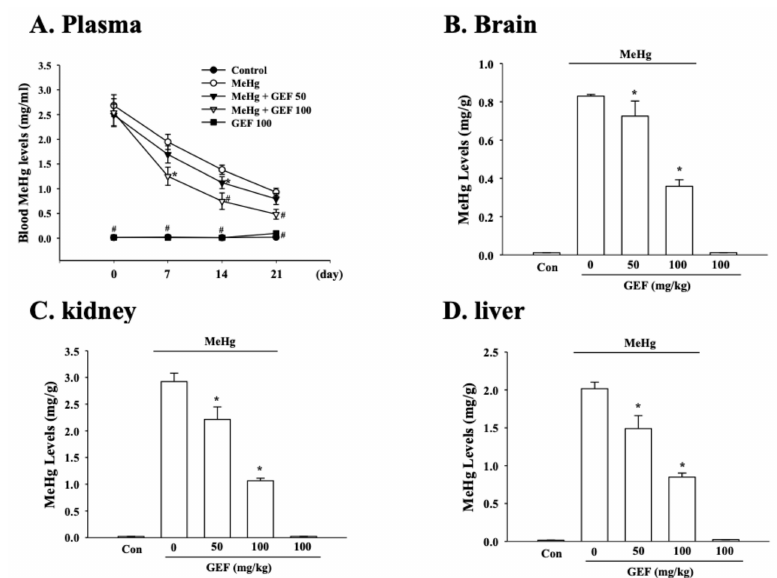
Figure 5. E ff ects of GEF on MeHg elimination after oral administration of MeHg. ( A ) Long-term treatment of GEF (50 and 100 mg / kg, 3 weeks, p.o.) after oral administration of MeHg (2 mg / kg, 3 weeks, p.o.) decreased plasma MeHg concentration with dose- and time-dependent manners. Each group are obtained plasma in every 7 day. ( B ) GEF eliminated brain MeHg concentration with dose-dependent manners. ( C ) GEF eliminated kidney MeHg concentration with dose-dependent manners. ( D ) GEF also eliminated liver MeHg concentration with dose-dependent manners. Hg concentration of brain, kidney, and liver were determined after 3 weeks of Hg administration. Data are presented as the mean ± SEM (n = 6; *p < 0.05, compared with MeHg treatment group, # p < 0.01, compared with MeHg treatment